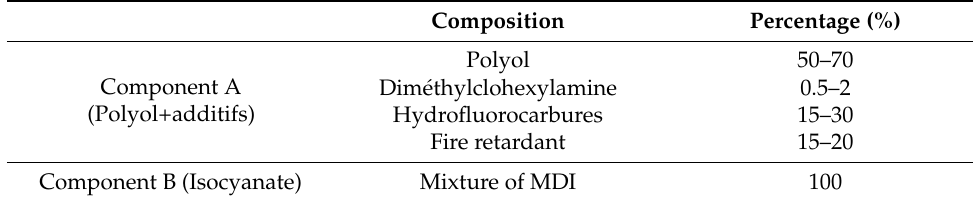
Table 1. Polyurethane foam